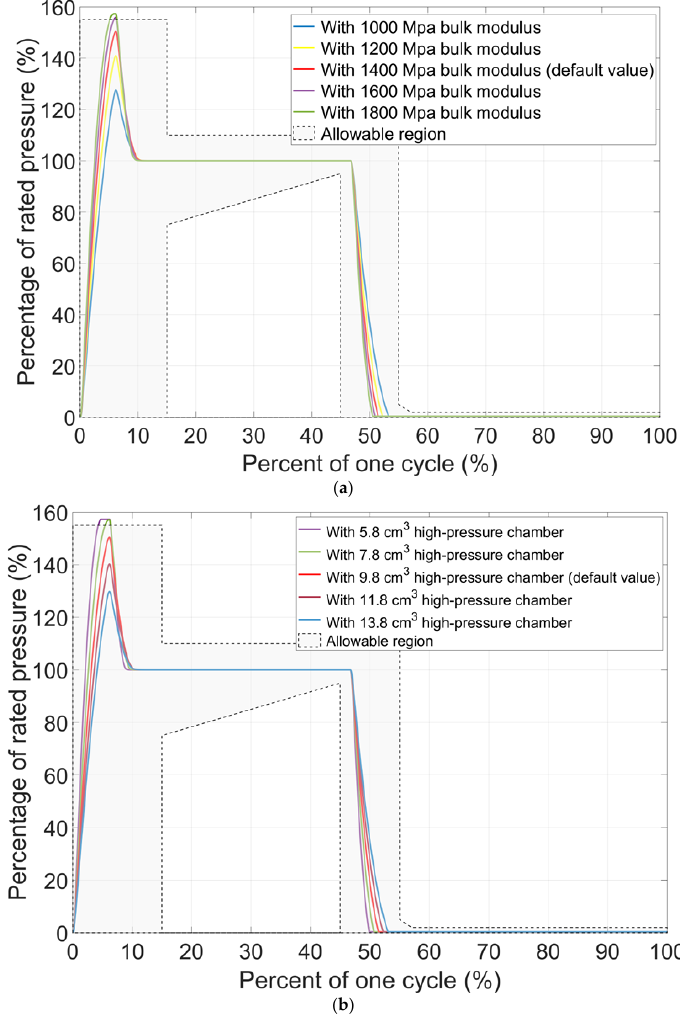
Figure 8. Evaluation of the unpredictable factors. ( a ) Effect of different values of the bulk modulus. ( b ) Effect of different volumes of the high-pressure